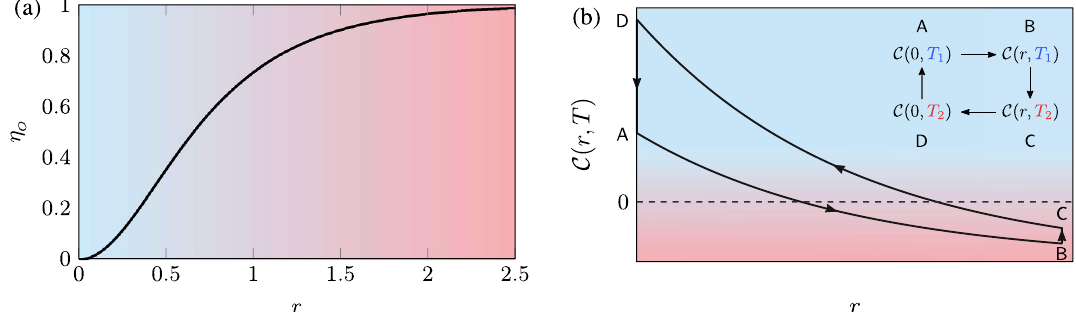
Figure 3. ( a ) Efficiency, η o , of the Otto heat engine as a function of the squeezing parameter. The efficiency does not depend on the temperature, but only on the squeezing parameter. The difference in colour indicates an increasing degree of non-classicality with r . In ( b ) we have the classicality function (10) in the Otto cycle as a function of the squeezing parameter for T 1 = (cid:31) ω/ k B and T 2 = 2 (cid:31) ω/ k B . In the inset, we present the diagrammatic representation of the Classicality function over the cycle. The blue and red-shaded denotes the classical, and non-classical regime,